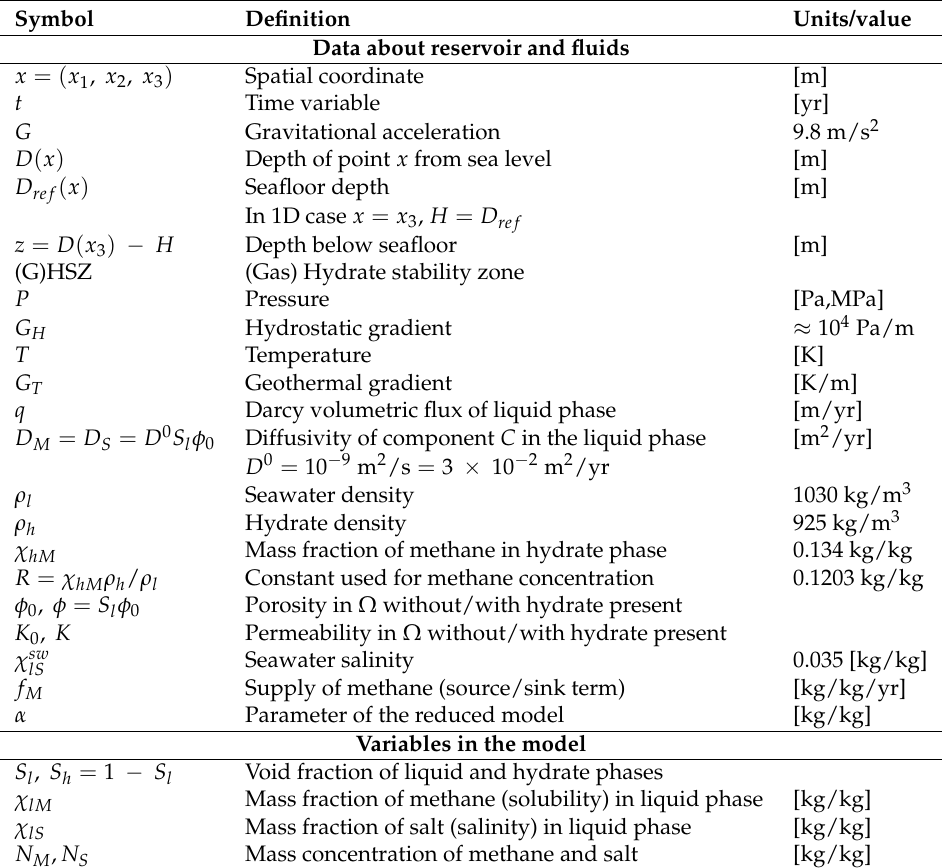
Table 1. Notation and definitions (kg/kg, per kg of liquid